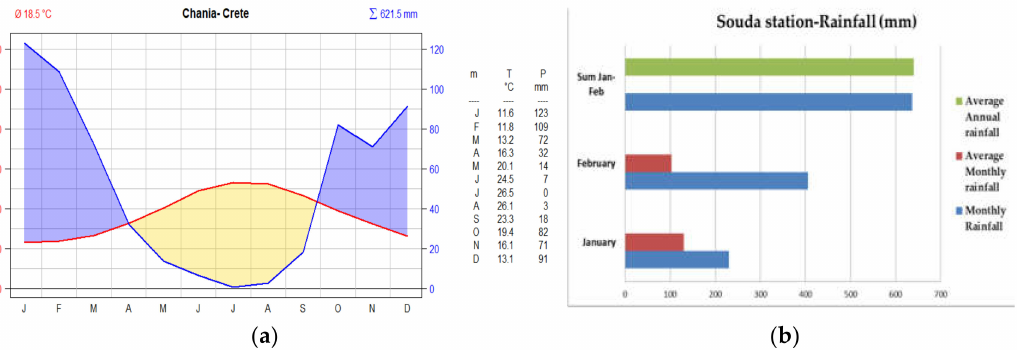
Figure 2. ( a ) Walter–Lieth diagram for Chania region illustrates the climatic variables of air temperature and precipitation, ( b ) The average annual, average monthly (January-February) and monthly rainfall amounts that recorded at Souda Weather Station